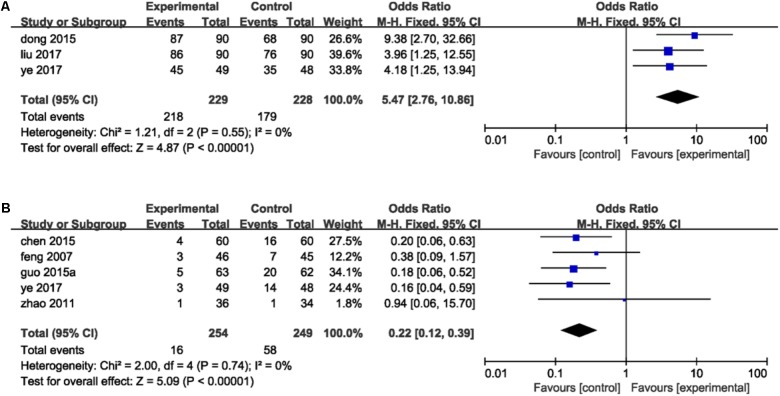
Forest plot of TER and MACE in patients treated with DHI + PCI and PCI alone. (A) The plot of TER, (B) the plot of MACE. I2 and P are the criterion for the heterogeneity test. ♦ Pooled odds ratio, —— odds ratio and 95%CI.